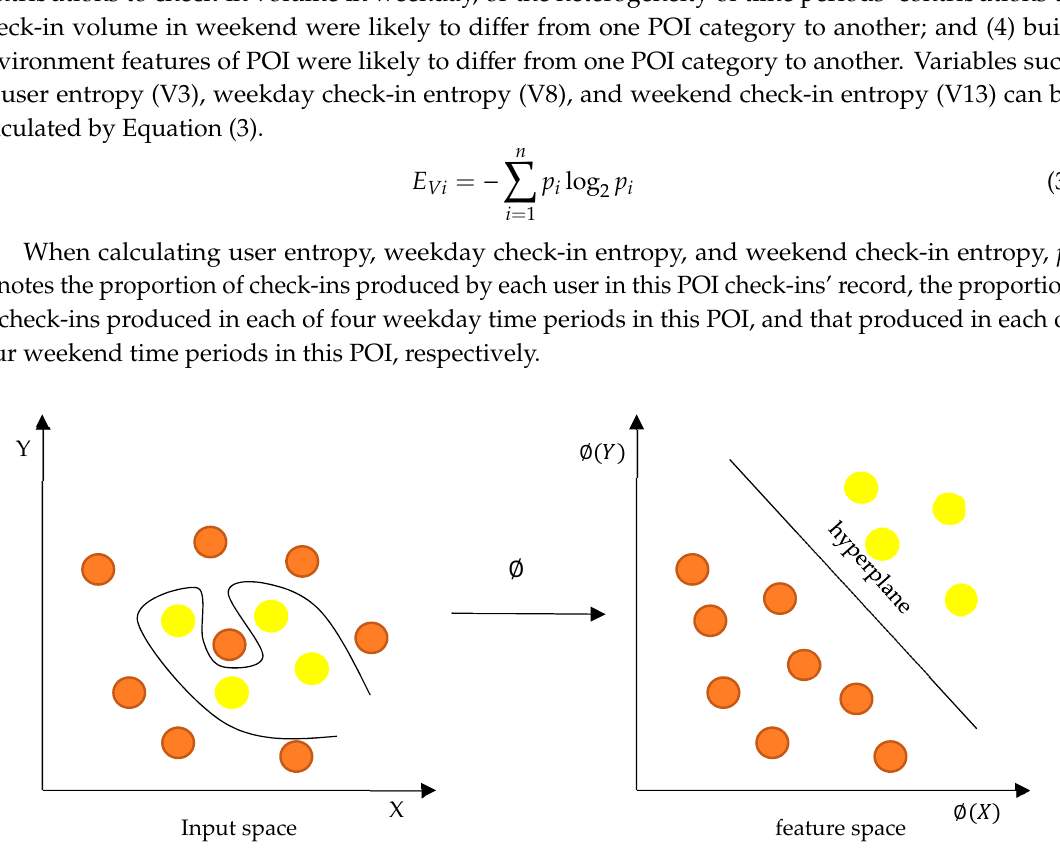
Figure 6. The representation of support vector machine (SVM).